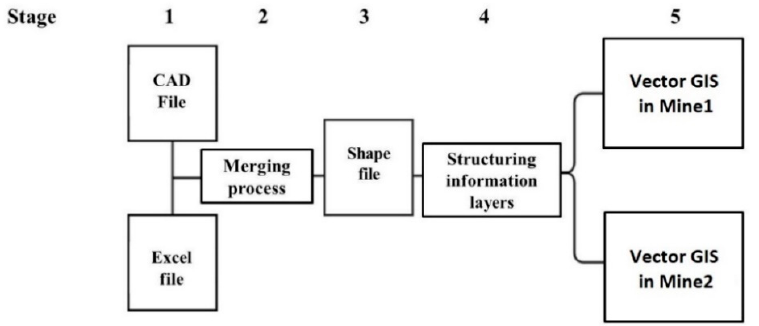
Figure 2. Scheme of the process followed to create the system.